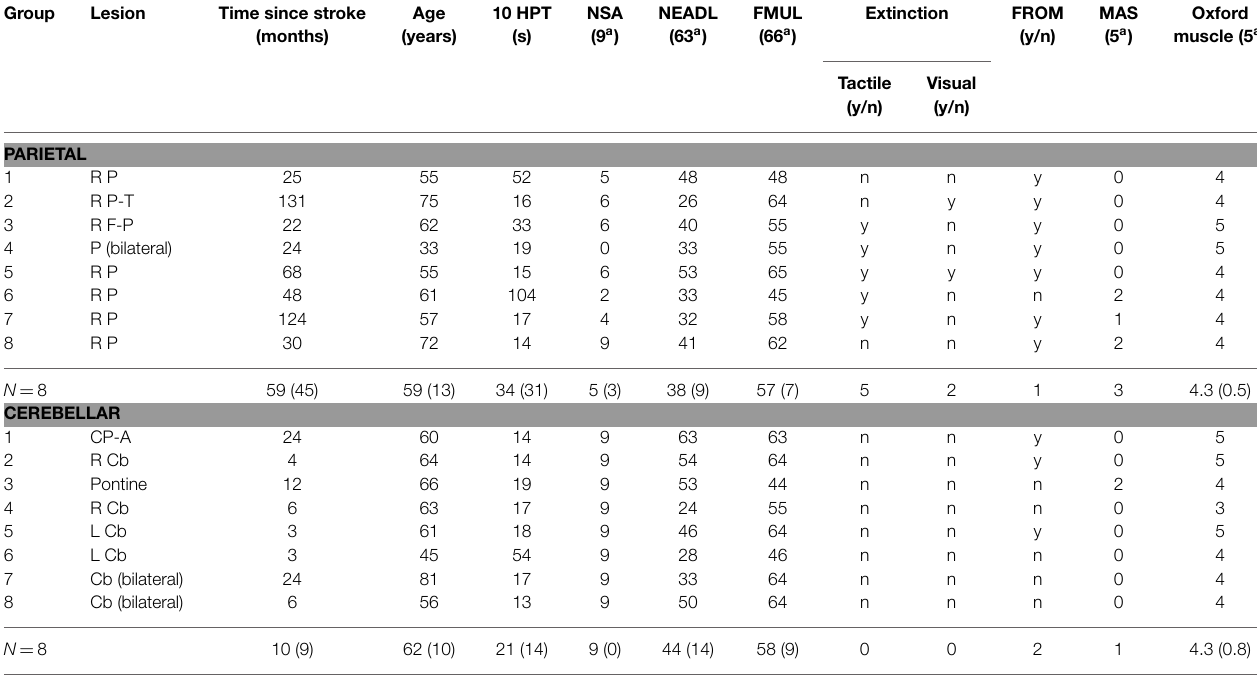
TABLE 1 | Participant characteristics with mean (SD)